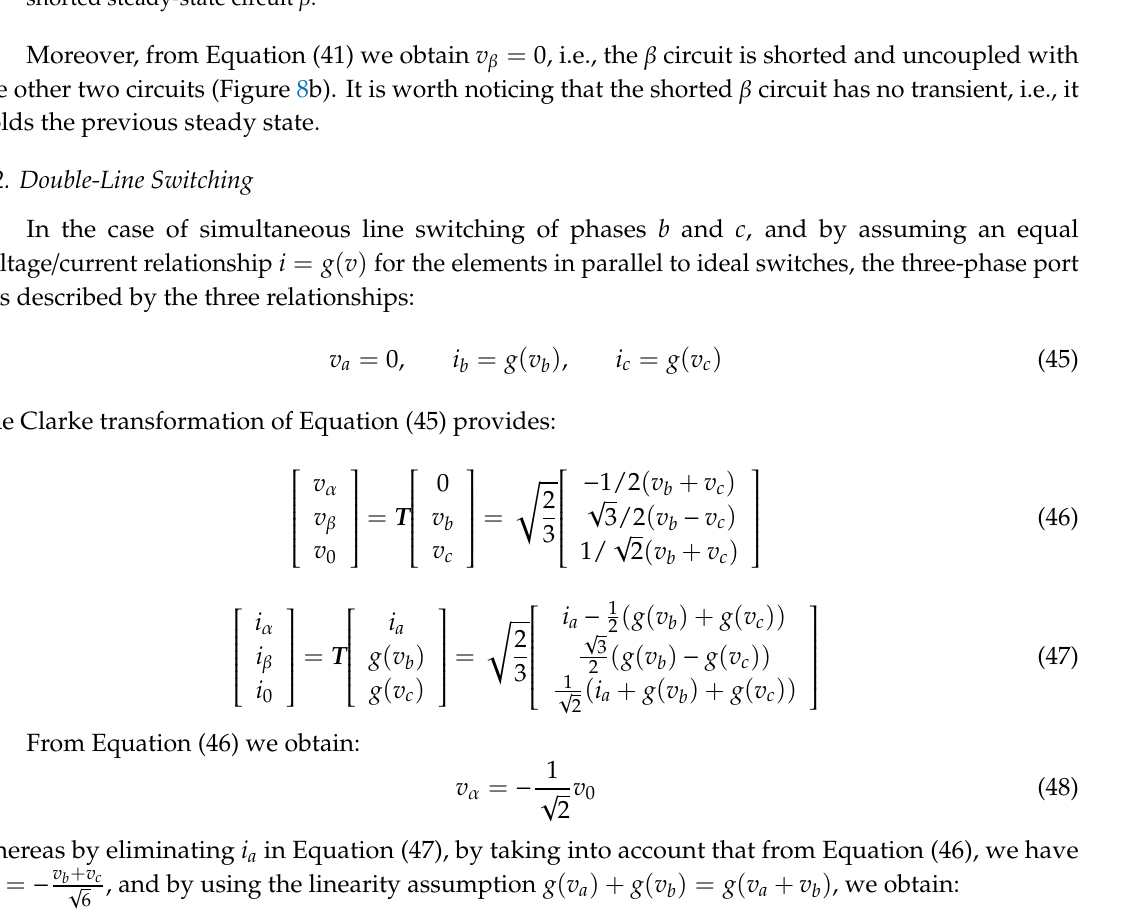
Figure 8. Connection of modal circuits in the time domain. Line switching of phases b and c results in ( a ) coupled α and 0 circuits through an ideal transformer with ratio k 1 = shorted steady-state circuit β